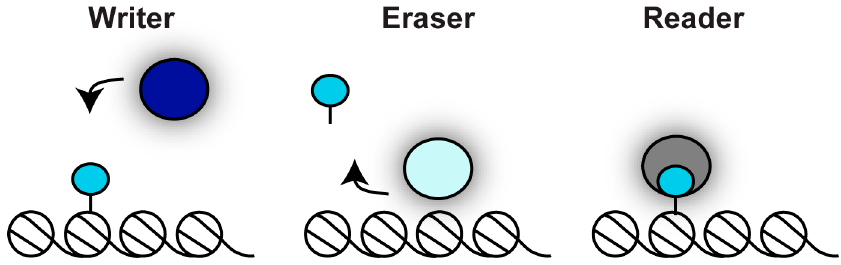
Figure 2. Chromatin writer–eraser–reader model. A chromatin mark (blue circle) is established by a writer enzyme and erased by an eraser enzyme. The chromatin mark is recognised by a specific binding protein: the reader.